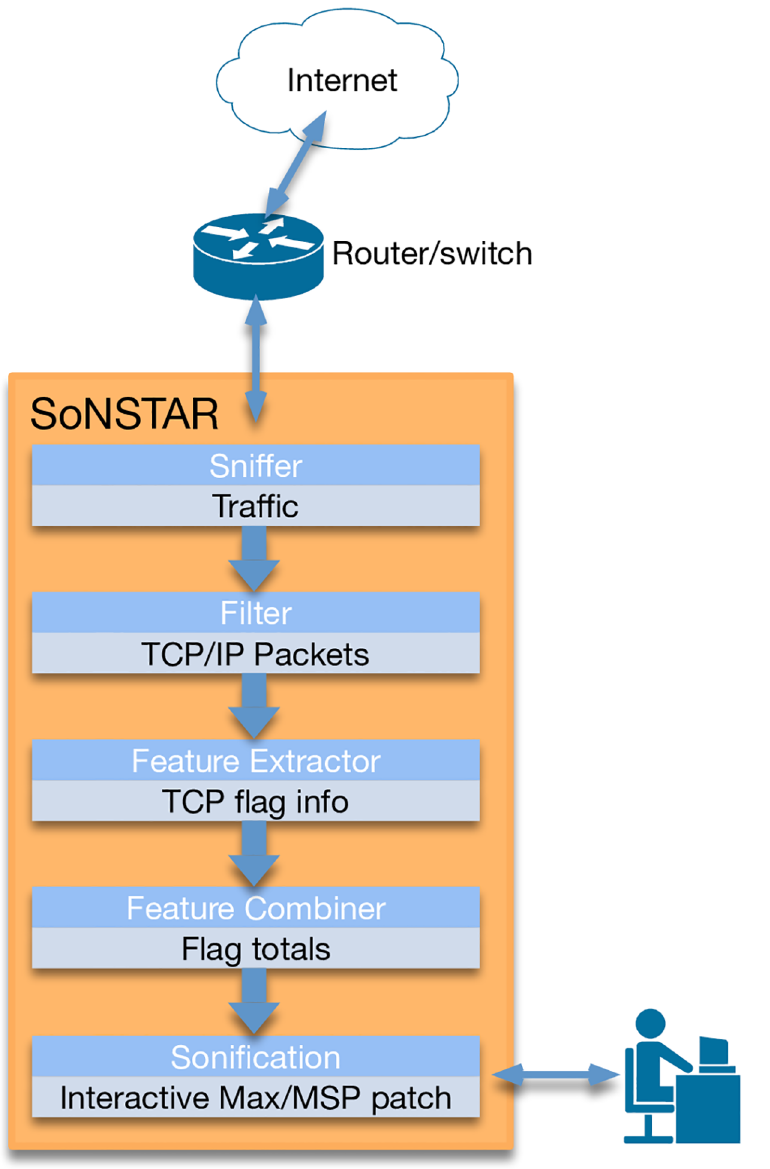
Fig 1. SoNSTAR architecture. The major components of the